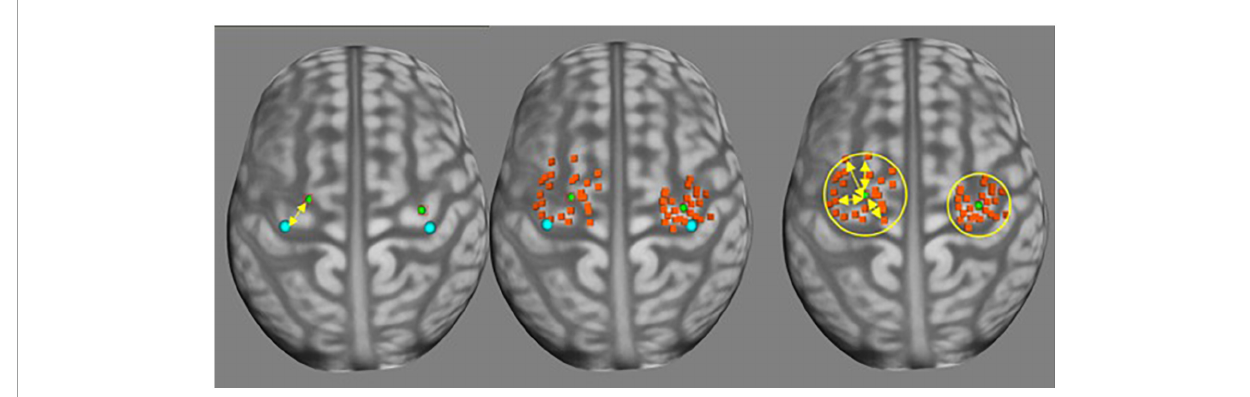
FIGURE1 Demonstration of (cid:49) L, SDpc, and VCpc over a standard tridimensional brain reconstruction. The blue dots are the reference points, green dots are CG points. The yellow arrow in the first panel represents (cid:49) L. Orange points in the second and third panels are positive motor points. In the third panel, the yellow circle depicts an approximation of SDpc and the yellow arrows are the distances used for obtaining VCpc.